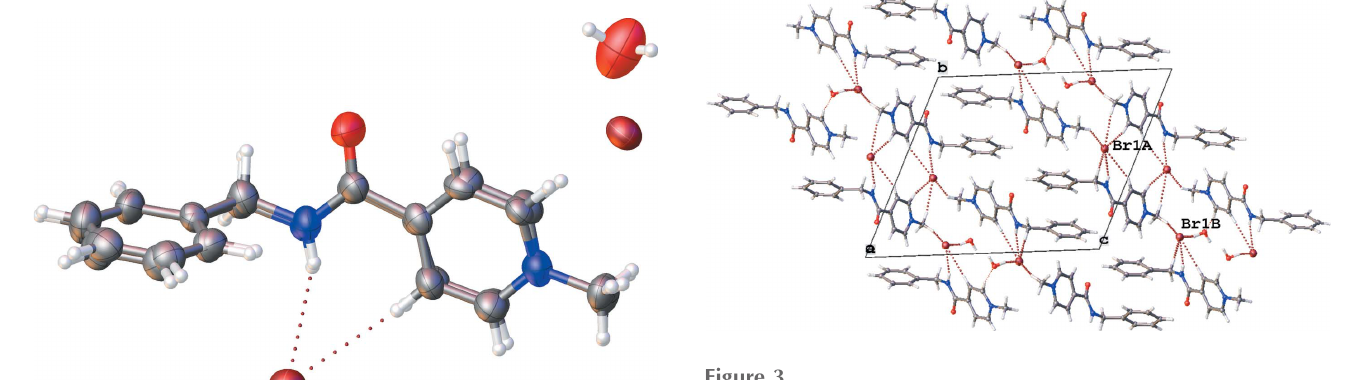
Figure 3 Crystal packing of AmBr hemihydrate in a view along [100]. Hydrogen- bonding interactions are shown by dashed lines.